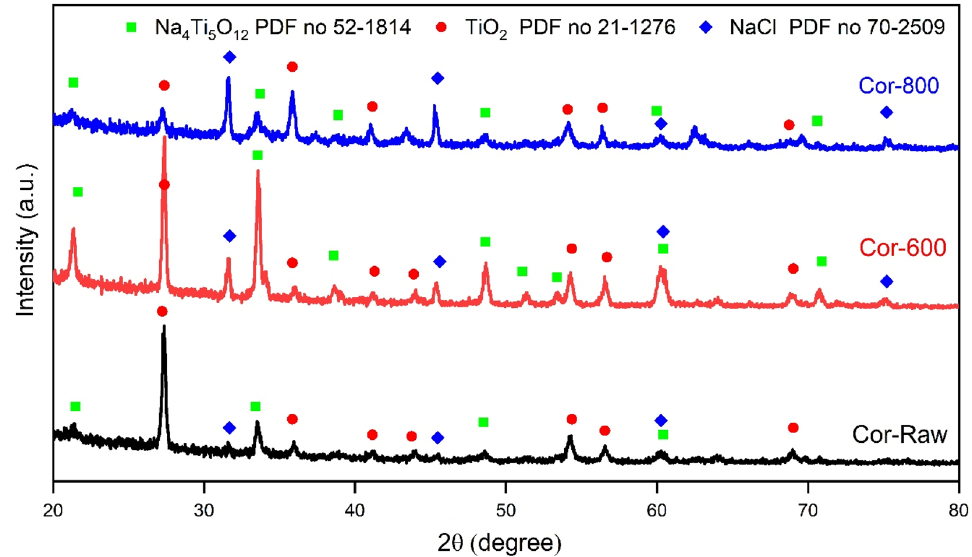
Figure 17. XRD patterns of raw and oxidized (600 and 800 °C/50 h) specimens after hot corrosion at 600 °C for 50 h.